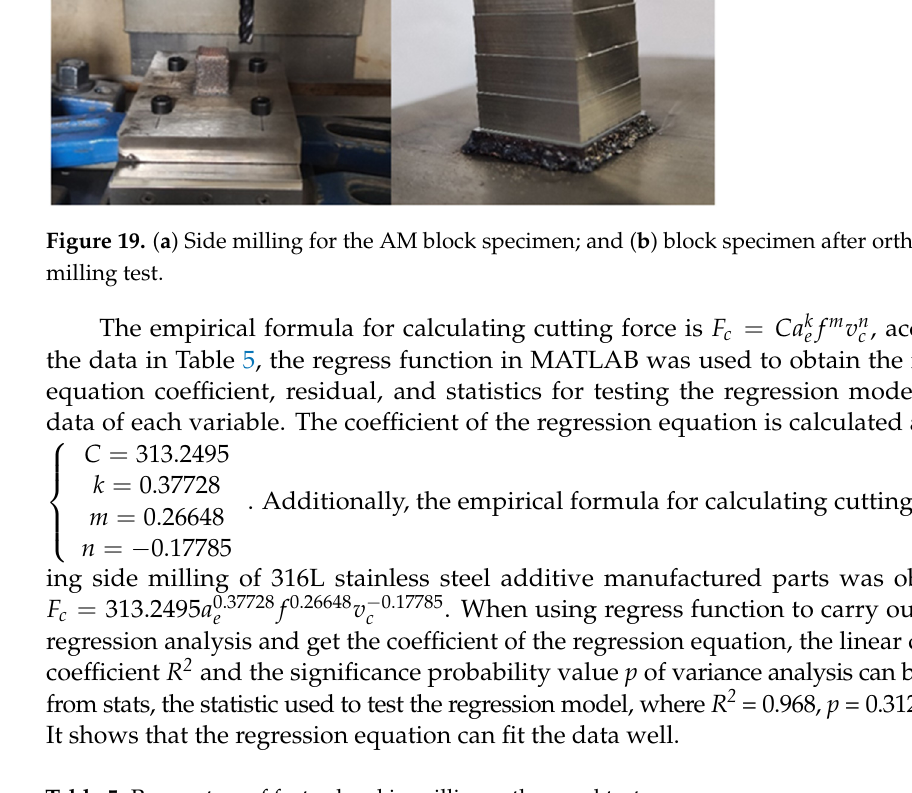
Table 5. Parameters of factor level in milling orthogonal test.